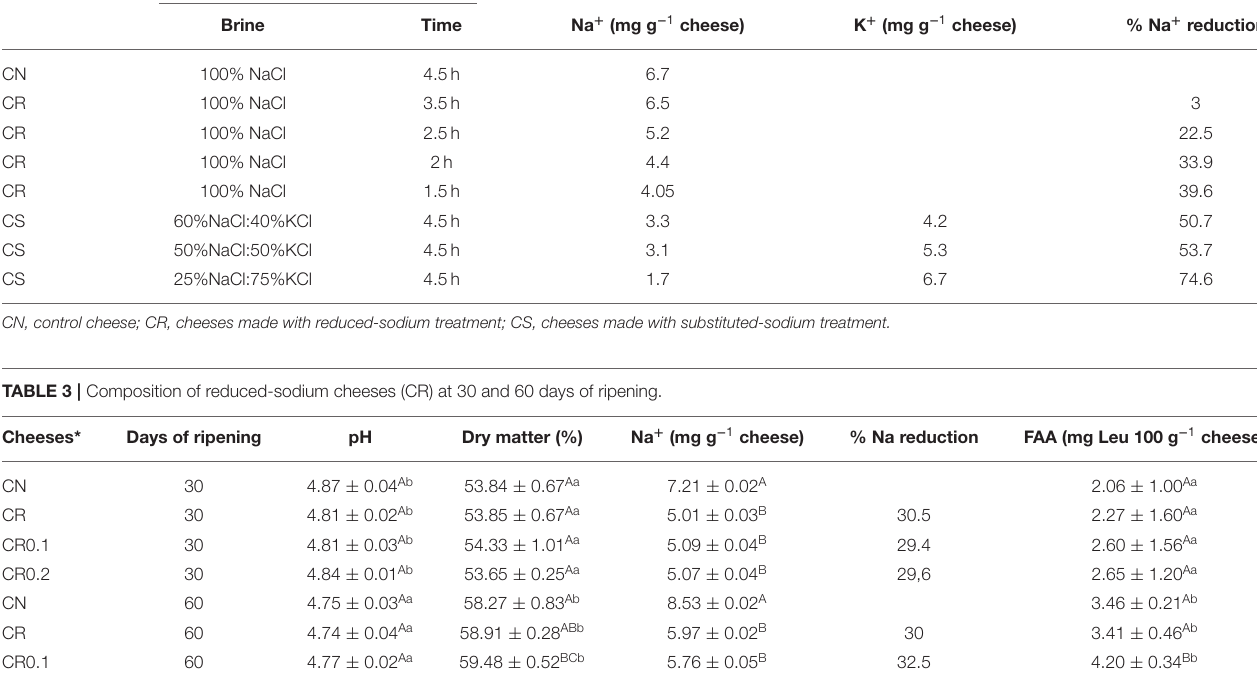
TABLE 2 | Sodium and potassium concentration of cheese. Cheese